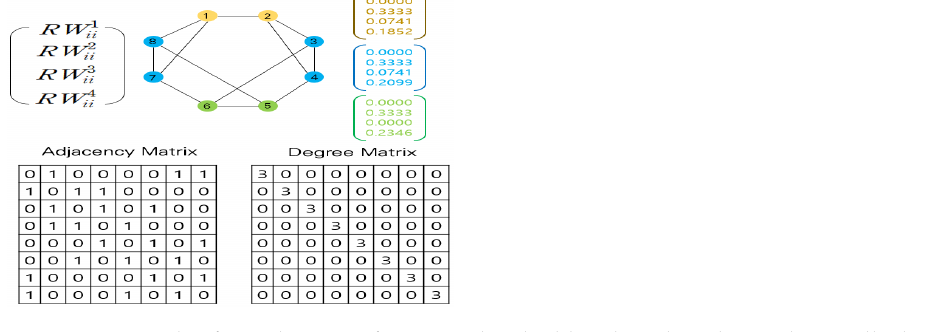
Figure 3. Example of initialization of positional embedding based on the random walk algorithm ( k = 4).